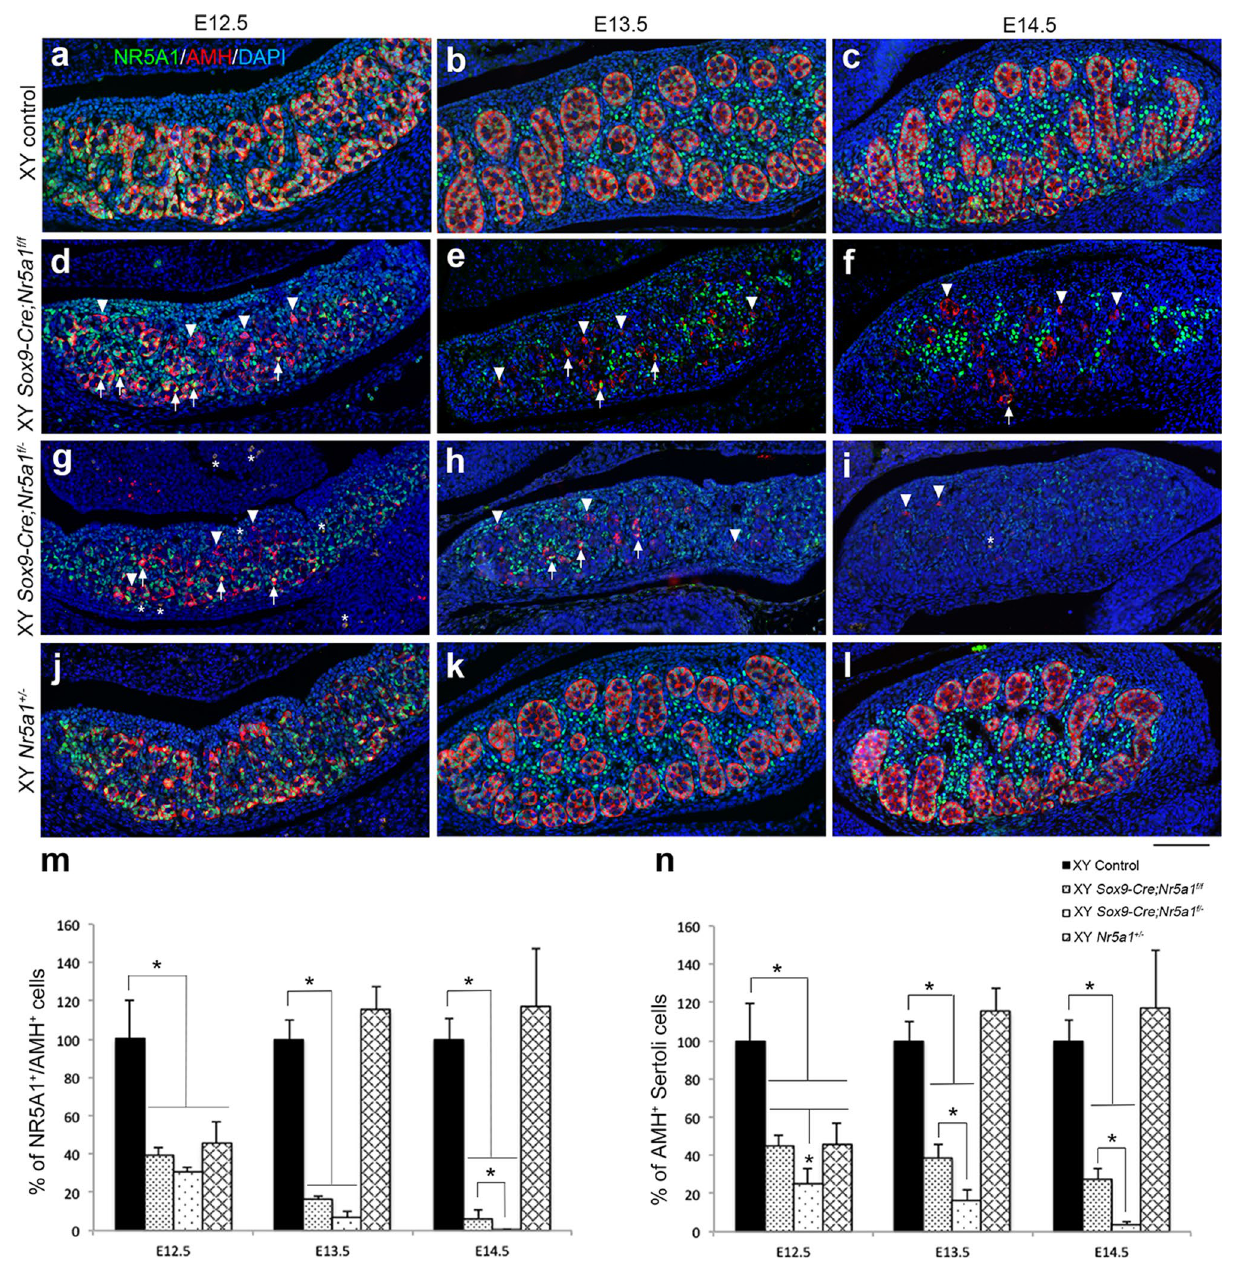
Figure 2. Nr5a1 inactivation in Sertoli cells during early embryonic development. Double IHC for NR5A1 (green) and AMH (red; Sertoli cell marker) in gonads of XY control ( a – c ), XY Sox9-Cre;Nr5a1f. /f ( d – f ), XY Sox9-Cre;Nr5a1f. /− ( g – i ), and XY Nr5a1 + /− ( j – l ) mice at E12.5, E13.5, and E14.5 (left, middle, and right panels, respectively). Arrows and arrowheads indicate representative NR5A1 + /AMH + and NR5A1 − /AMH + cells, respectively. White asterisks in ( g ) and ( i ) indicate nonspecific autofluorescence. Ventral, anterior, and posterior sides of gonads are upwards, right, and left, respectively. Nuclei are stained blue with DAPI. Scale bar, 100 µm. Ratios (%) of NR5A1 + /AMH + ( m ) and AMH + ( n ) cells. (Daily values for XY control were set at 100%). Data are shown as means ± SEM (n = 3). * P < 0.05 vs. XY